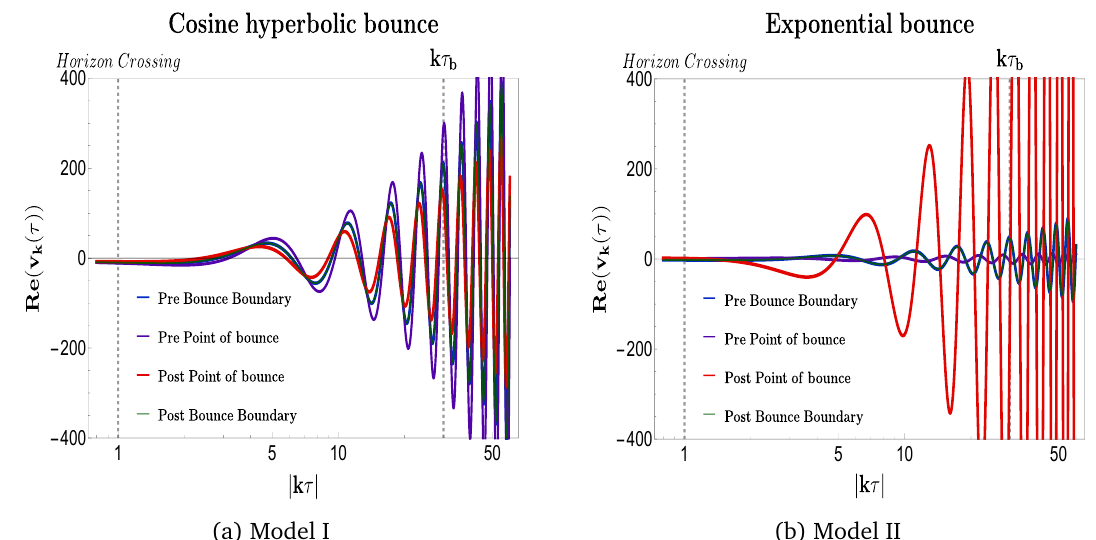
Figure 7: The real part of v for the Cosine hyperbolic and the exponential bounce k has been plotted. We can see the behaviour of v in the sub-horizon region | k τ | (cid:29) 1. k ) is slightly negative for the Cosine hyperbolic Around the Horizon crossing, the Re ( v k bounce whereas it is almost zero for the exponential bounce. Far from the horizon crossing, the behaviour of both the models is almost identical. It slowly starts rising before becoming highly oscillatory with increasing amplitude and frequency as they ≈ 30. The field variables in all regions behave approach the point of bounce k τ b almost similarly. However, a noticeable difference between the two models lies in the fact that the amplitude of the field variable for a particular region is in contrast for both the models. If the amplitude is maximum for a particular region for model-I then it is minimum for